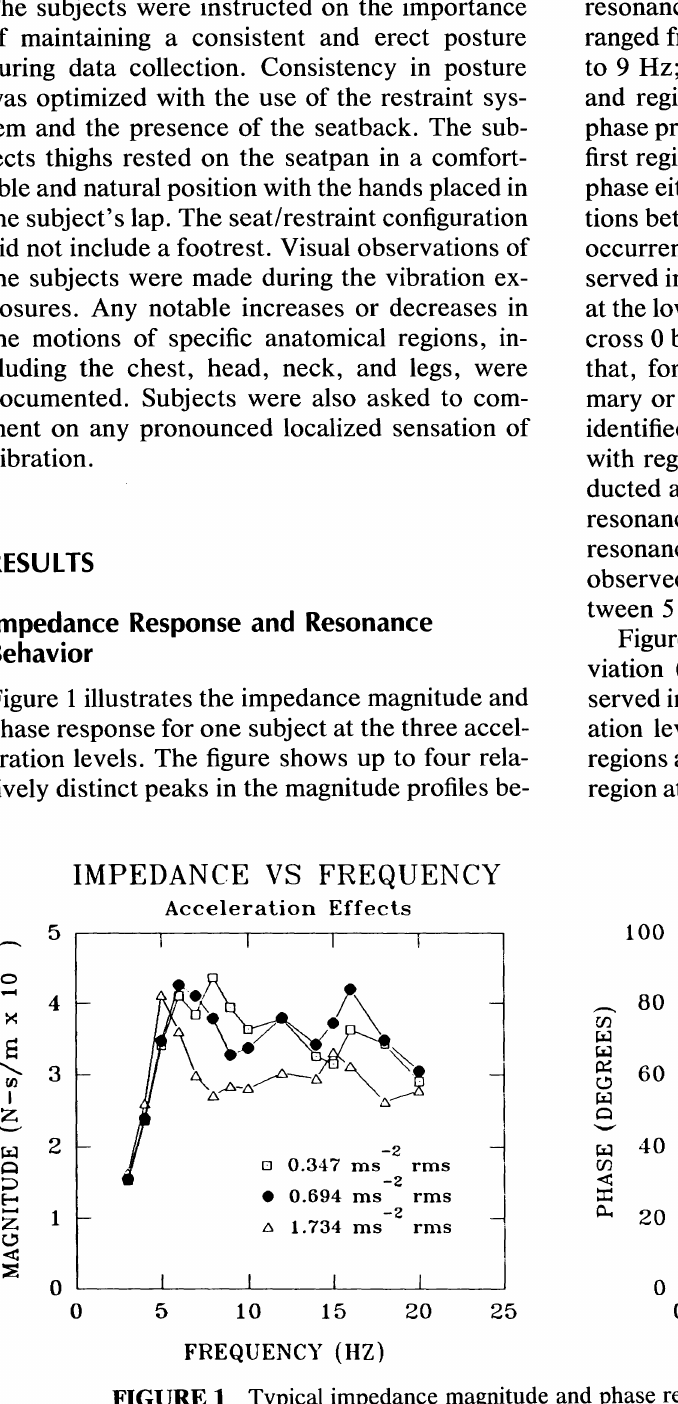
FIGURE 1 Typical impedance magnitude and phase responses at the three acceleration levels (one